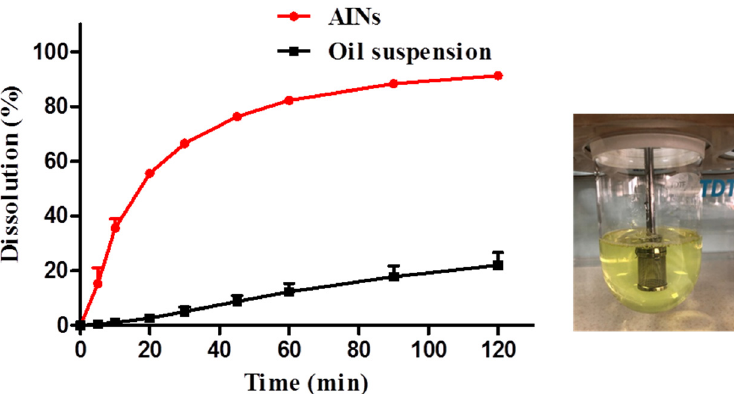
Figure 9. Dissolution profiles of lyophilized AINs and an oil suspension of icaritin ( n = 6). AINs: amorphous icaritin nanoparticles.